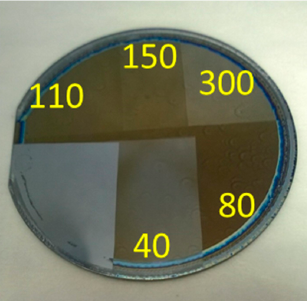
Figure 10. UV cured octamolybdate demonstrating film “burn off” and/or condensation (estimated units in J/cm 2 ). units in J/cm 2